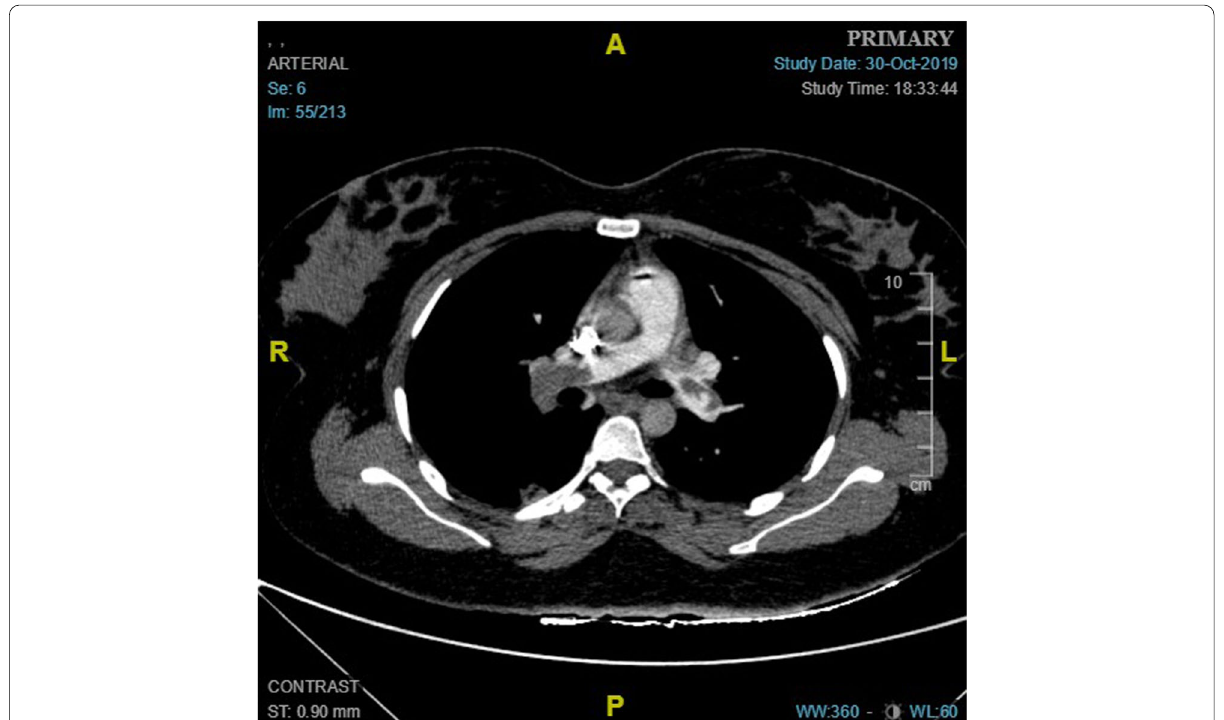
Fig. 3 Computed tomography pulmonary angiography (CTPA) was done which revealed the presence of thrombus in distal main pulmonary